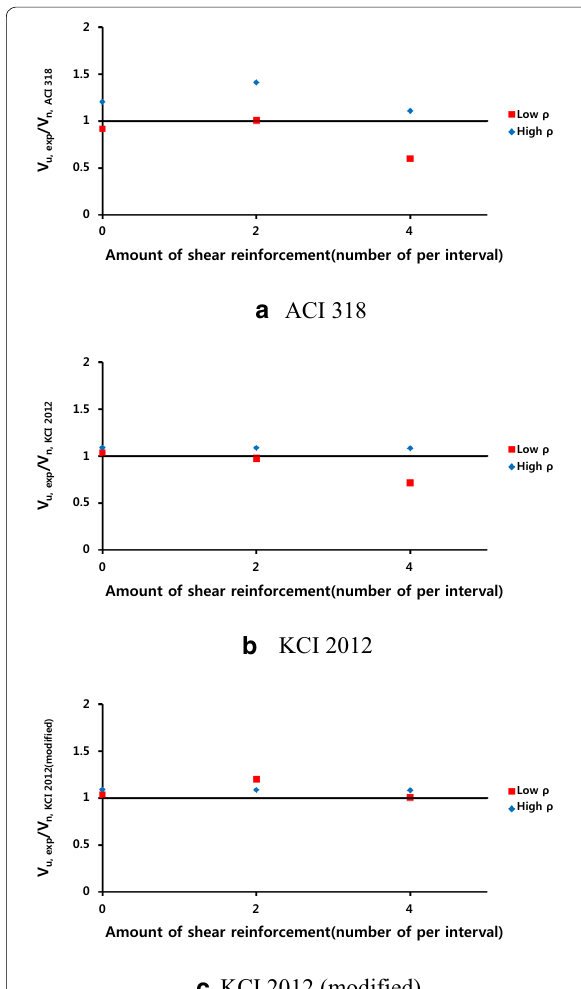
Fig. 9 Comparison of punching shear strengths by concrete code and proposed